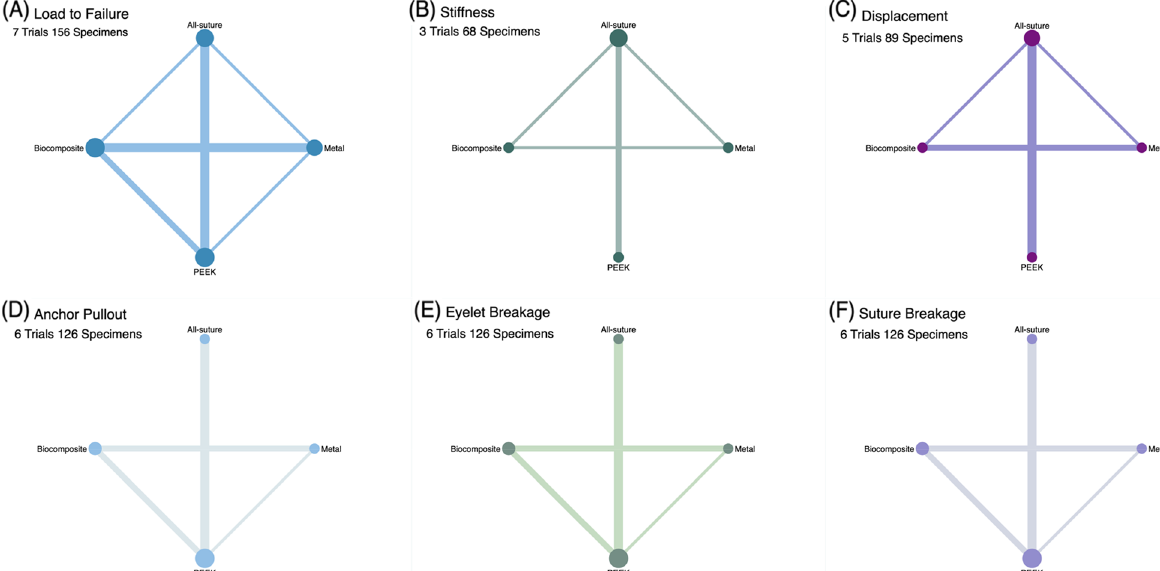
Fig. 2 Summary of Network Geometry of Each Biomechanical Property. The size of straight lines is proportional to the number of studies, and the size of round nodes is proportional to the number of interventions. Direct and indirect evidence were combined for multiple treatment comparisons. A All included studies reported failure load values; therefore, all anchors had connections with each other. B Three studies had stiffness values, and ( C ) five studies had displacement values and a lack of direct connections from PEEK to the biocomposite and metal anchors. ( D – F ) Six studies reported failure mode rates and a lack of direct connections from all‑suture anchors to biocomposites and metal